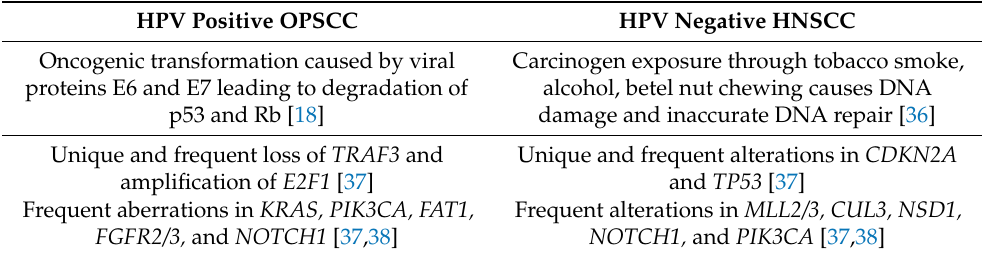
Table 1. Characteristic molecular alterations in HPV positive and HPV negative